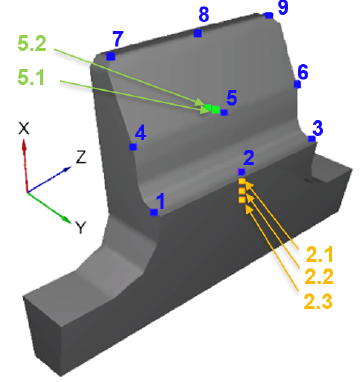
Figure 2. Measurement points